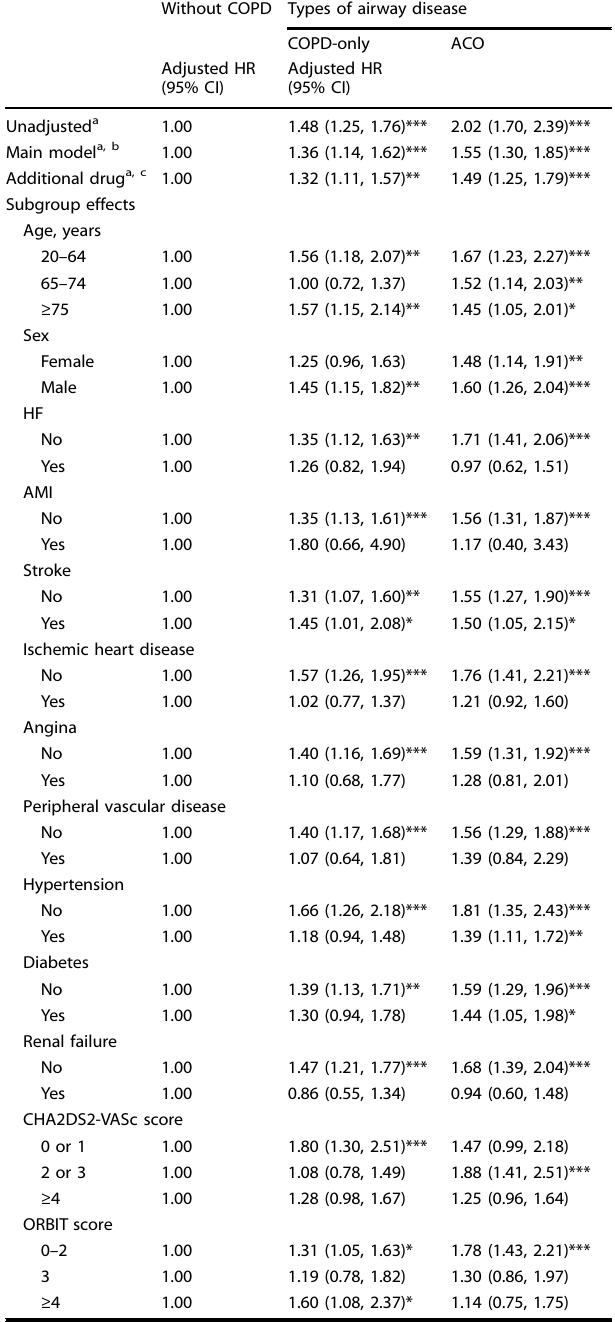
Table 4. Risk of VA with respect to asthma – COPD overlap. Without COPD Types of airway